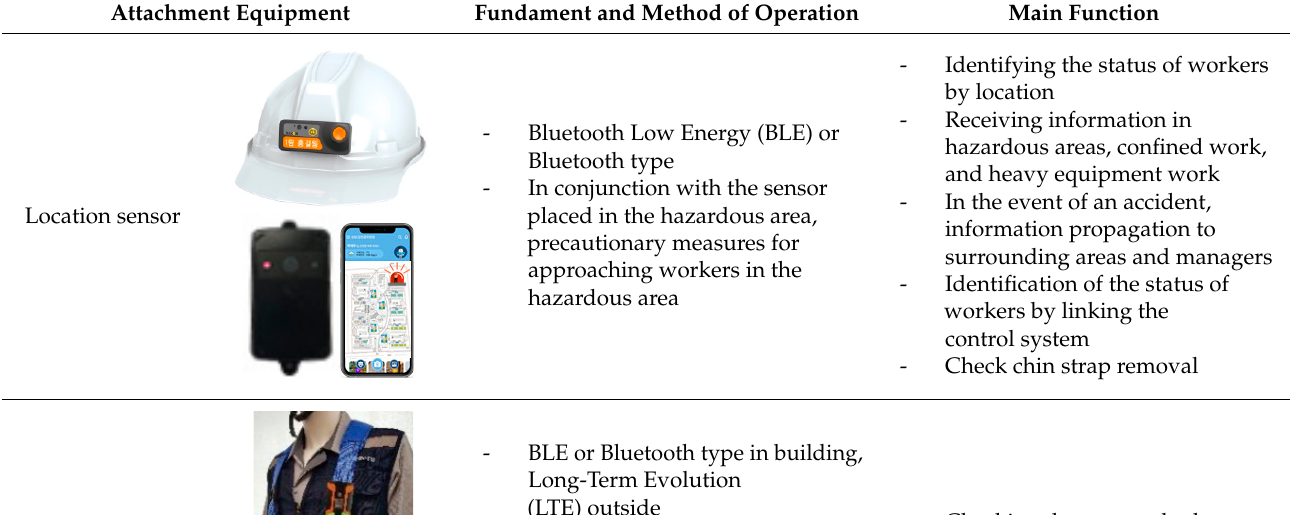
Table 2. Major smart safety equipment with attachment type.